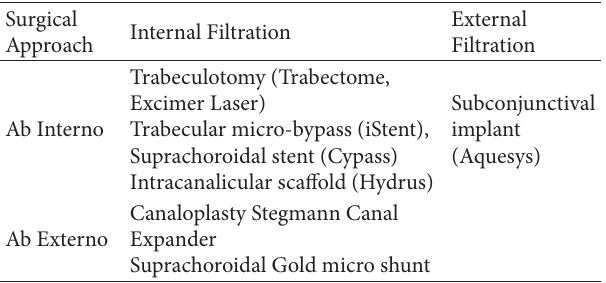
Table 1: Overview of current glaucoma procedures with MIGS.